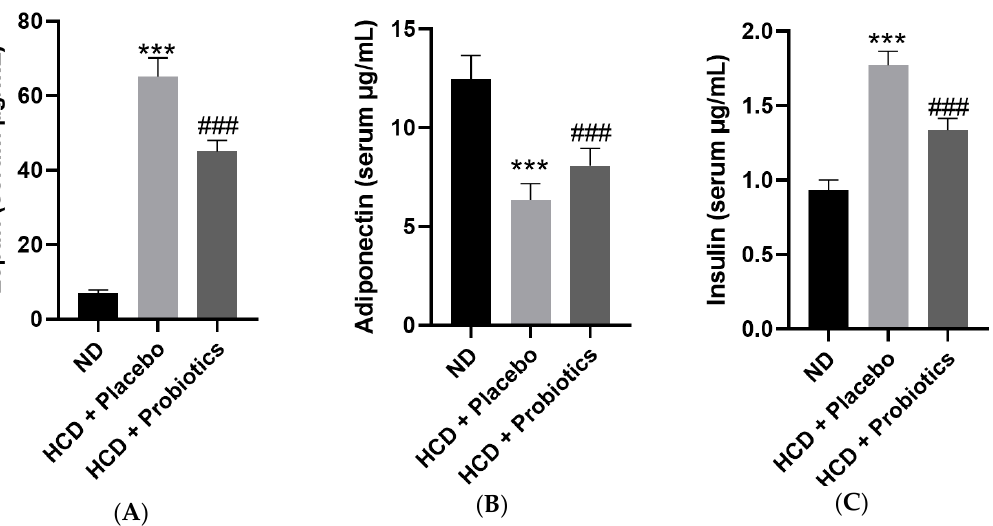
Figure 6. Effect of MSPs on serum adipokine levels in HCD-fed mice. ( A ) Serum leptin level. ( B ) Serum adiponectin level. ( C ) Serum insulin level. Data are expressed as mean ± standard deviation ( n = 5 per group). *** p < 0.001 vs. ND; ### p < 0.001 vs. HCD + placebo. Legend: HCD, high-carbohydrate diet; ND, normal diet.